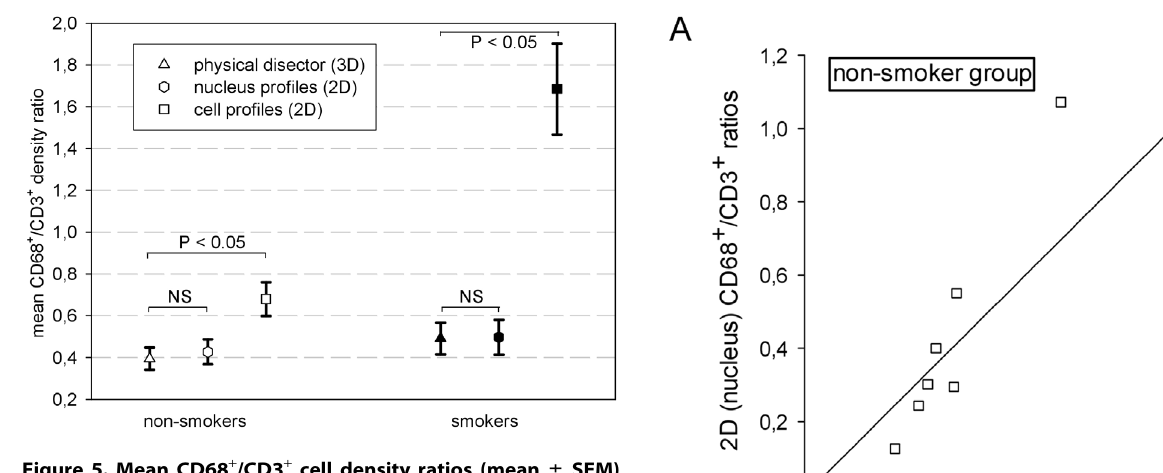
Figure 5. Mean CD68 + /CD3 + cell density ratios (mean ± SEM) for each design and study group.